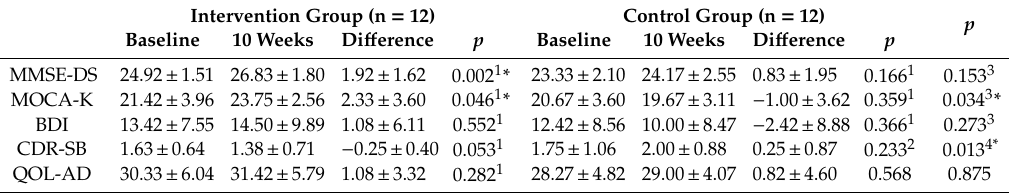
Table 2. The comparison of clinical outcomes between baseline and post-intervention in both the groups.